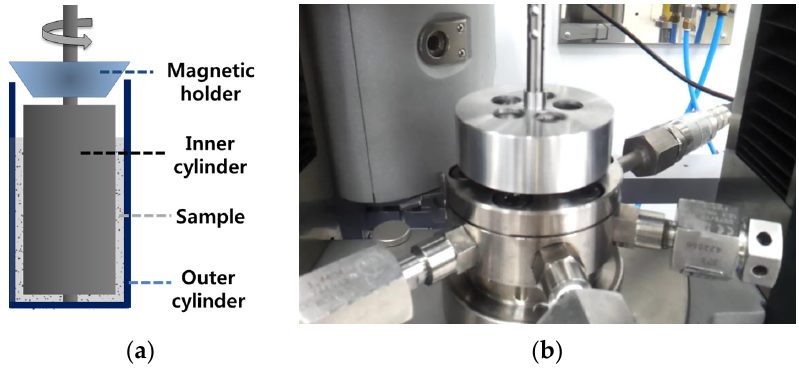
Figure 2. ( a ) Schematic of the high ‐ pressure cell and ( b ) the setup launched in the rheometer.